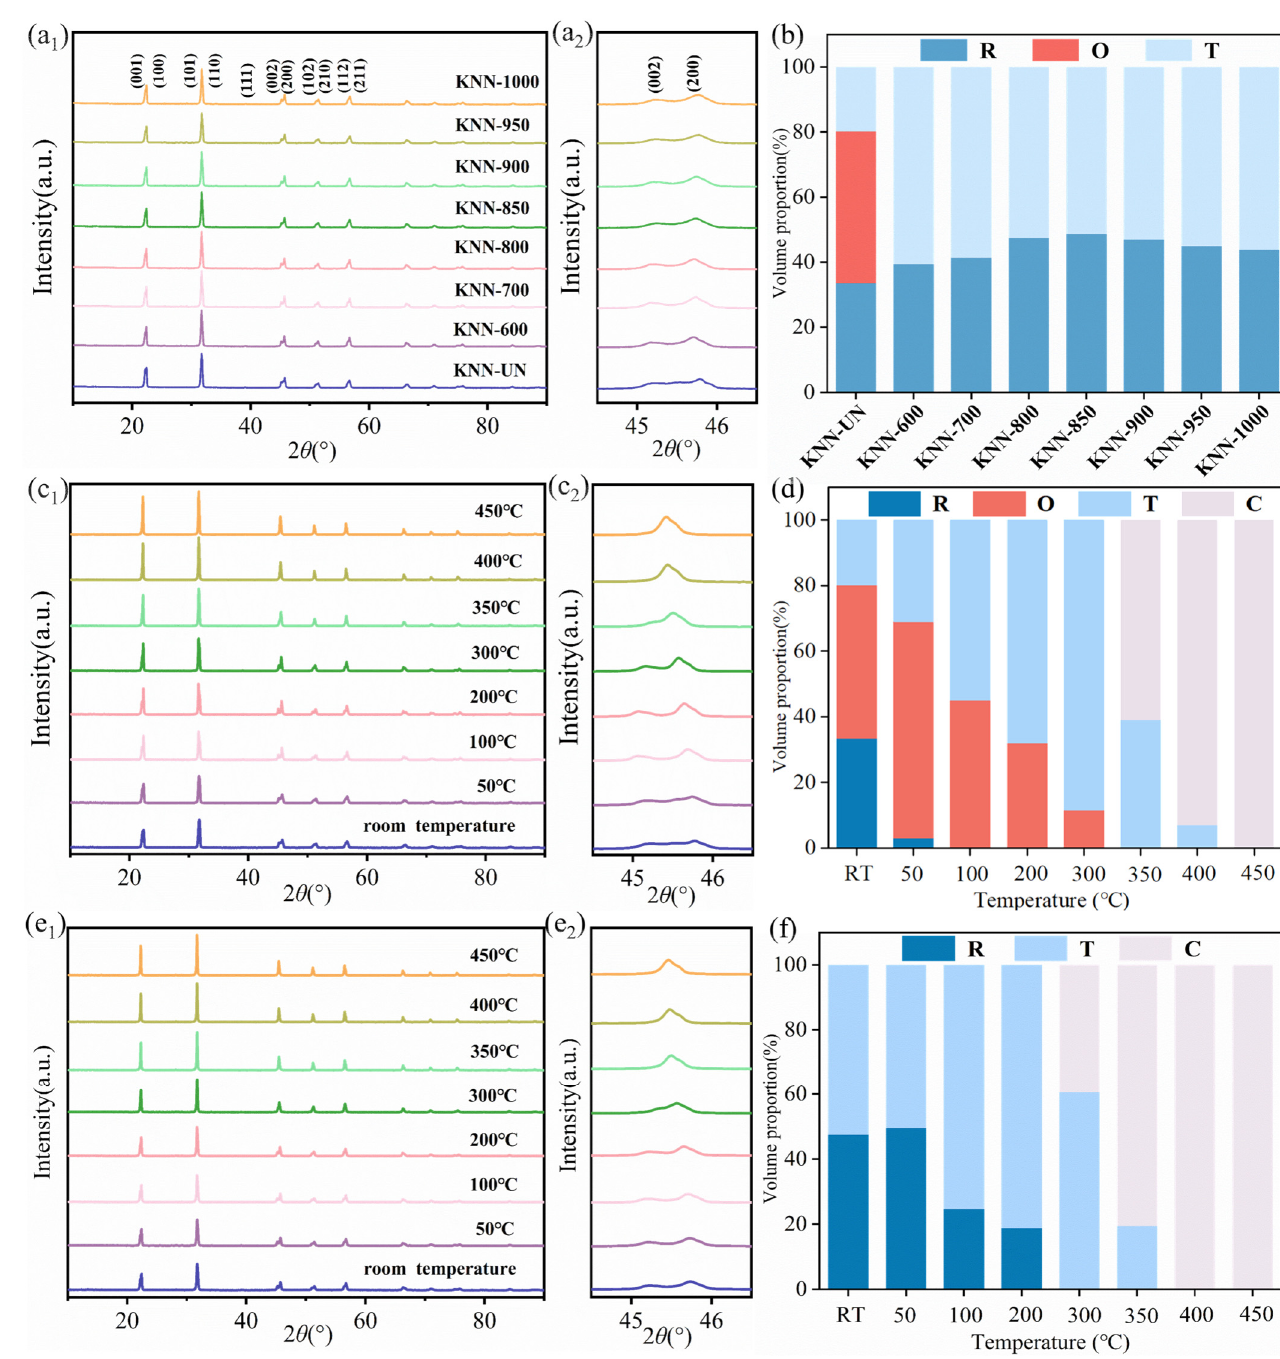
Figure 2. ( a 1 ) XRD pattern of KNN-BNZ-Fe ceramics, in the following range: 10 ° < θ < 90 °; ( a 2 ) 44 ° ( a1 ) XRD pattern of KNN-BNZ-Fe ceramics, in the following range: < θ < 47 °. ( b ) The phase content of KNN-BNZ-Fe ceramics with different Nb 2 O 5 precursors; ( c 1 ) XRD 10 ◦ < θ < 90 ◦ ; ( a2 ) 44 ◦ < θ < 47 ◦ . ( b ) The phase content of KNN-BNZ-Fe ceramics with differ- patterns of KNN-UN measured from room temperature to 450 °C , in the following range: 10 ° < θ < ent Nb 2 O 5 precursors; ( c1 ) XRD patterns of KNN-UN measured from room temperature to 450 ◦ C, in 90 °; ( c 2 ) 44 ° < θ < 47 °. ( d ) The change in phase content of KNN-UN from room temperature to 450 °C ; ( e 1 ) XRD patterns of KNN-800 measured from room temperature to 450 °C , in the following range: 10 ° < θ < 90 °; ( e 2 ) 44 ° < θ < 47 °;.( f ) The change in phase content of KNN-800 from room temperature to 450 °C. to 450 ◦ C, in the following range: 10 ◦ < θ < 90 ◦ ; ( e2 ) 44 ◦ < θ < 47 ◦ ;.( f ) The change in phase content